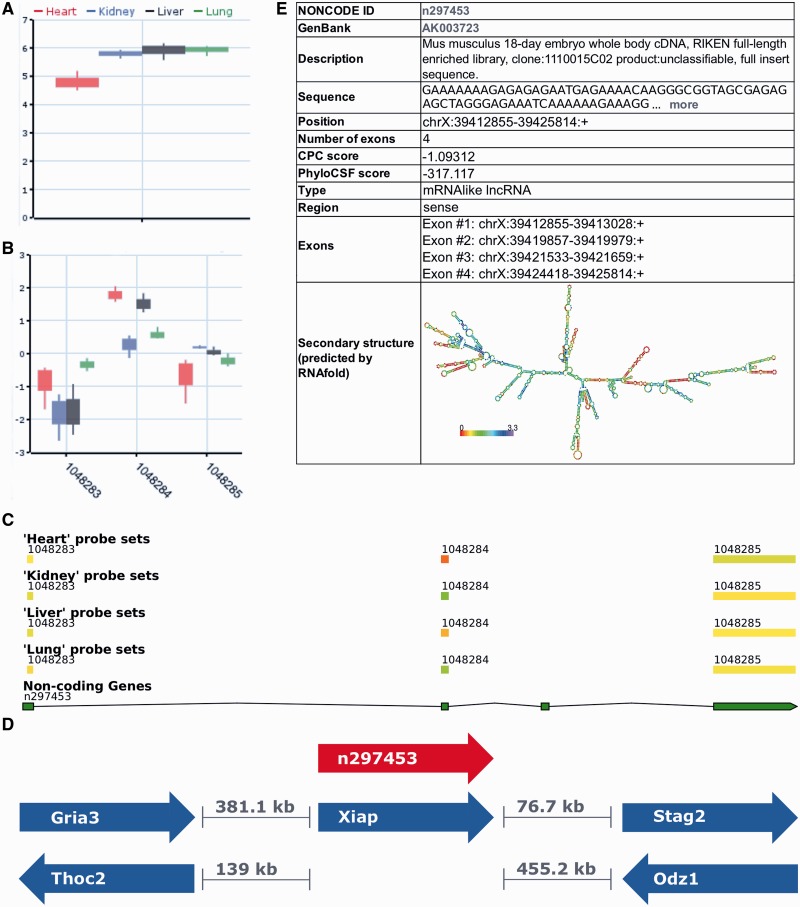
Features of noncoder. Noncoder provides various features: (A) Box-and-Whisker plot of transcript cluster and (B) GNIs. This lncRNA is not differentially expressed between the kidney and liver, but a probe set has a high GNI difference. (C) The graphical representation of the same lncRNA as above in our built-in genome browser. A probe set with the high difference in GNI is coloured to show lower expression in the kidney (green) than liver (orange). (D) Noncoder provides a schematic overview of the location of the lncRNA to other genes. (E) A table with the detailed annotation information about each lncRNA of a cluster. Besides the genomic location and GenBank description, it shows the non-coding prediction score (from CPC and PhyloCSF), the location to protein-coding genes (‘Region’) and predicted secondary structure.